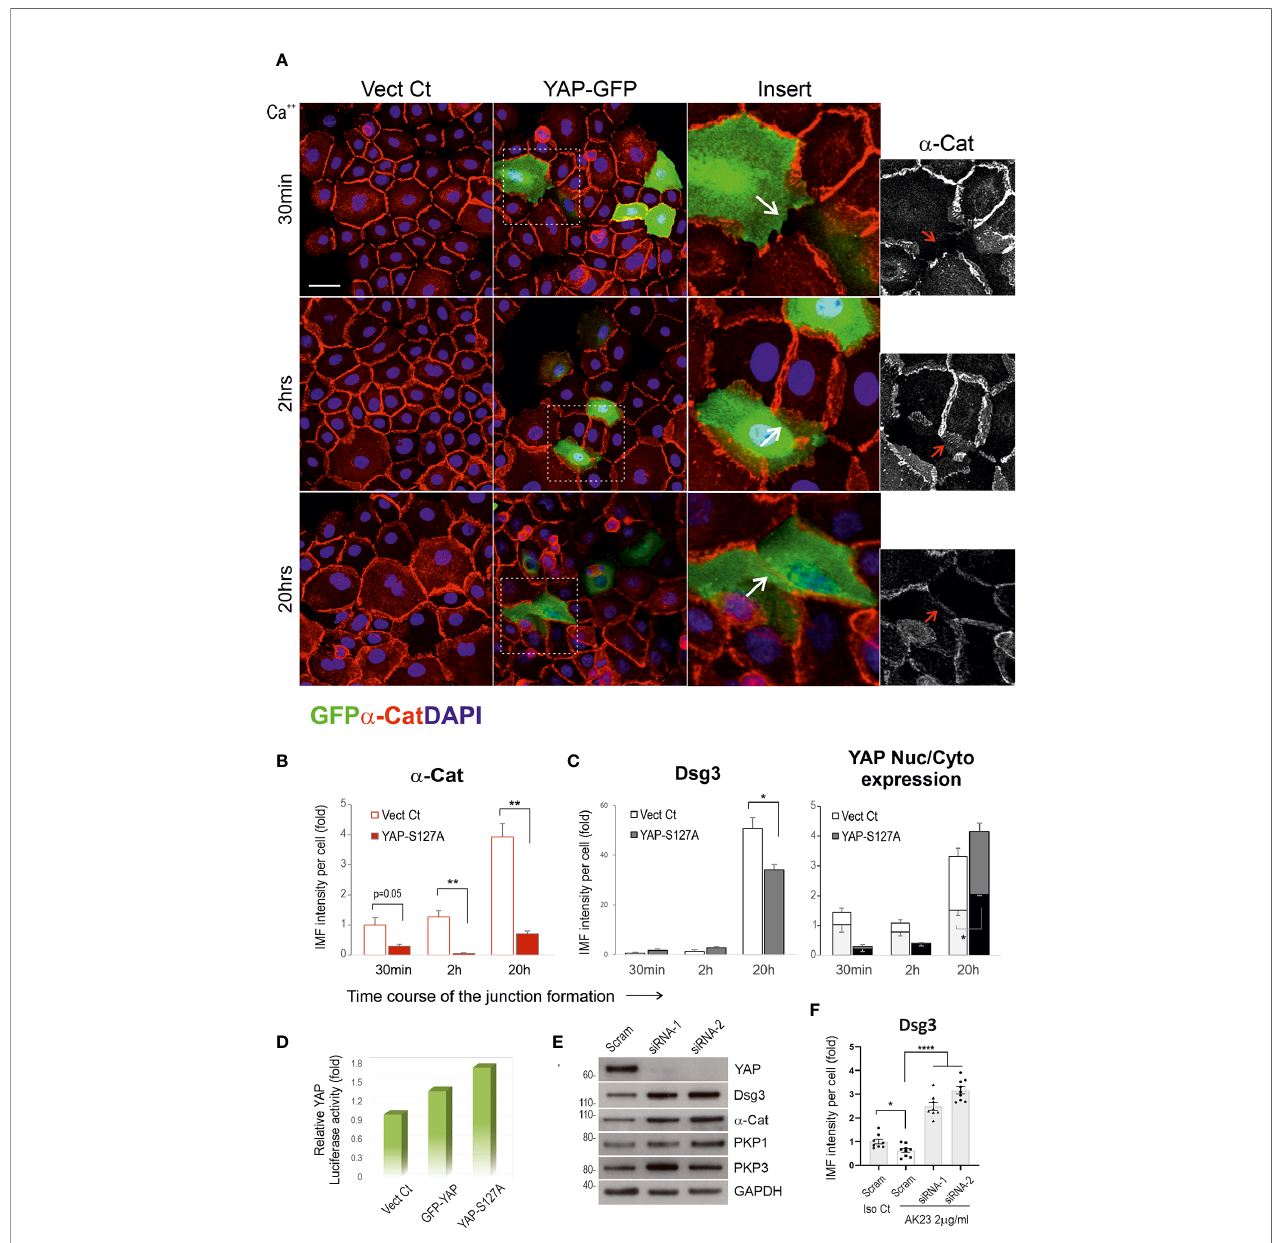
FIGURE 7 | Expression of exogenous YAP causes disruption in the junctional assembly of a -catenin and Dsg3. (A) Confocal images of N/TERTs transfected with GFP-YAP or empty vector plasmid (Vect Ct), double-stained for GFP (green) and a -catenin (red). Cells were seeded at 2.5x10 5 per well on coverslips in a 24-well plate in KSFM to reach ~70% con fl uence. The next day, the mediums were changed to KGM and cells were incubated for various periods before fi xation (2 experiments). Inserts showed enlarged fi elds of the square boxes with GFP positive cells in which disruption of a -catenin at cell junctions was evident. (B) Image quantitation for a -catenin staining in cells transfected with YAP-S127A plasmid or Vect Ct and cells were treated in the same way as described in (A) . A signi fi cant reduction in a -catenin expression was detected at 2 hours and 20 hours, especially at the later time point, compared to controls (n=5 fi elds/sample, 2 experiments, **p < 0.01). (C) Image quantitation for Dsg3 (with 5H10) and YAP staining in a parallel set of coverslips that indicated increased nuclear YAP in cells transfected with YAP-S127A compared to Vect Ct cells (n=5 fi elds/sample, 2 experiments, *p < 0.05). A reduction of Dsg3 was also detected at 20 hours ’ time point in YAP-S127A transfected cells compared to control (*p < 0.05). (D) YAP luciferase assay indicated a trend of increased luciferase activities in both GFP-YAP and YAP-S127A transfected cells compared to Vect Ct. (E) Western blotting for the indicated proteins in N/TERTs transfected with either scrambled (Scram) or siRNA-1/2. Increased expression of cell adhesion proteins was shown in YAP knockdown cells compared to controls (at least 3 experiments, unpublished data in other cell lines). (F) Image quantitation of Dsg3 staining in N/TERTs transfected with scrambled (Scram) or siRNA-1/2 and treated with isotype IgG control (Iso Ct) and AK23 (2µg/ ml), respectively. 1x10 5 siRNA transfected cells were seeded in 96-well in KSFM overnight before IgG treatment in calcium-containing (1.2mM) KSFM for 24 hours. It showed YAP depletion resulted in a 2~3-fold increase of Dsg3 expression compared to Scram control cells treated with Iso Ct IgG, which blunted the effect of AK23 induced Dsg3 reduction (n=8~9 fi elds/sample, *p < 0.05, ****p < 0.0001). Scale bars,